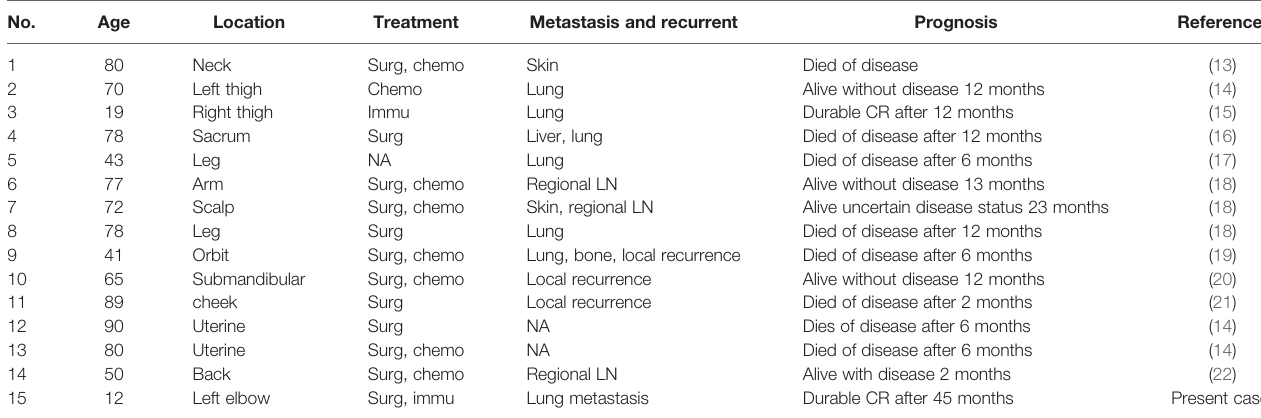
TABLE 2 | Fifteen cases of refractory PRMS including this